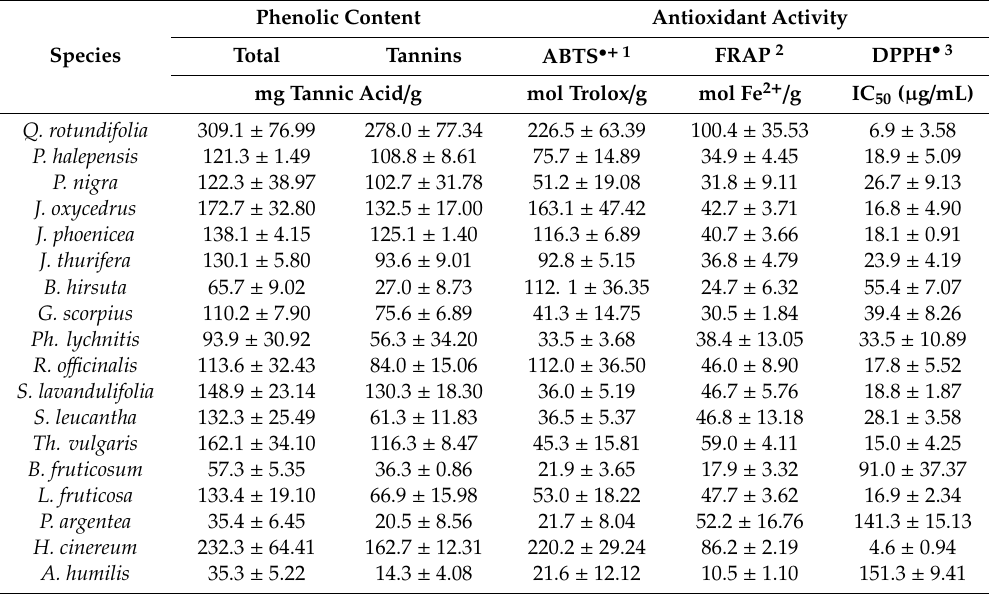
Table 4. Antioxidant activity of the species that were bitten at least twice by sheep during the autumn grazing.